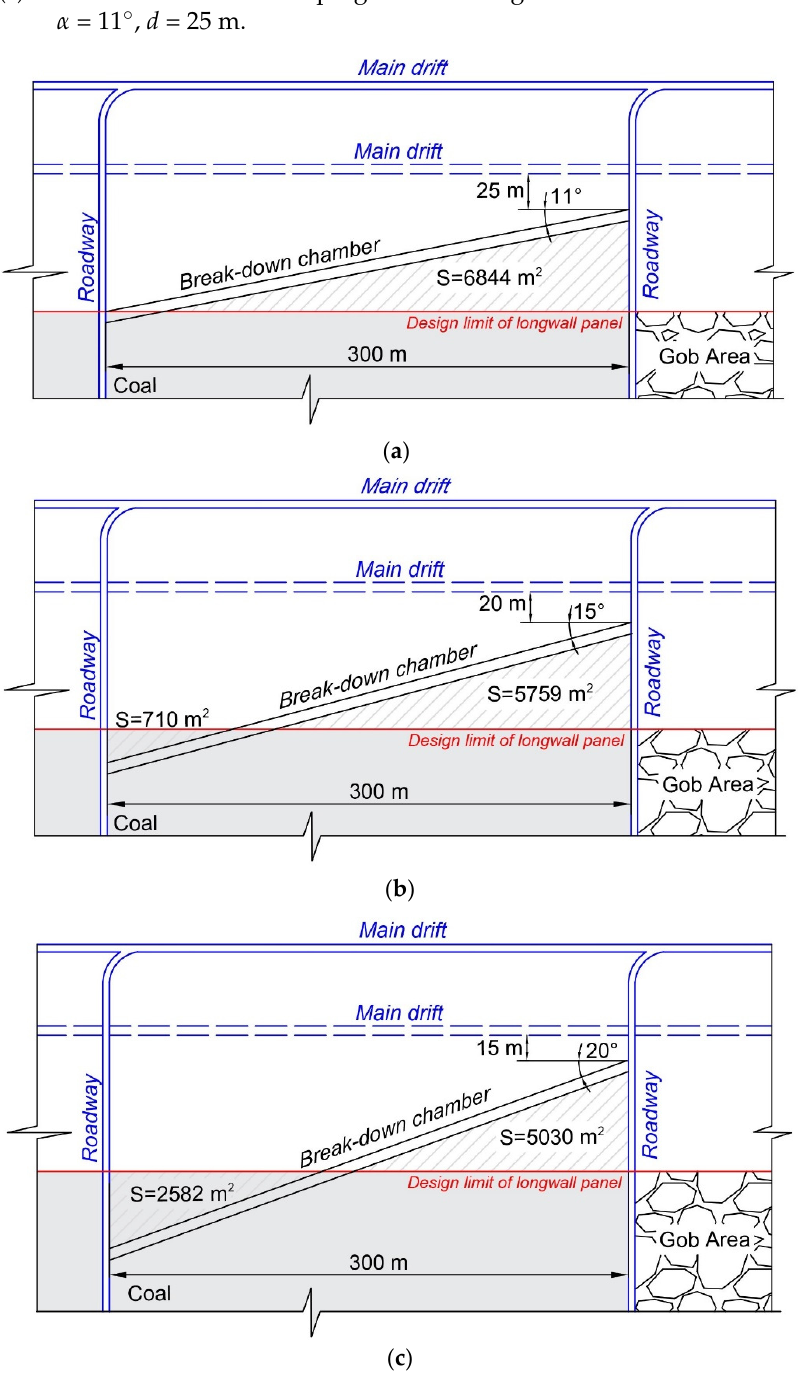
Figure 3. ( a – c ) Locations of the mine workings and parameters of the protection way of the main workings in the form of left pillars (swung by 180°).